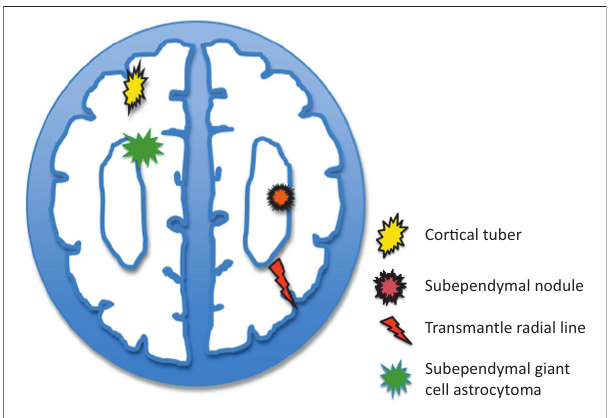
Cor(cid:28)cal tuber